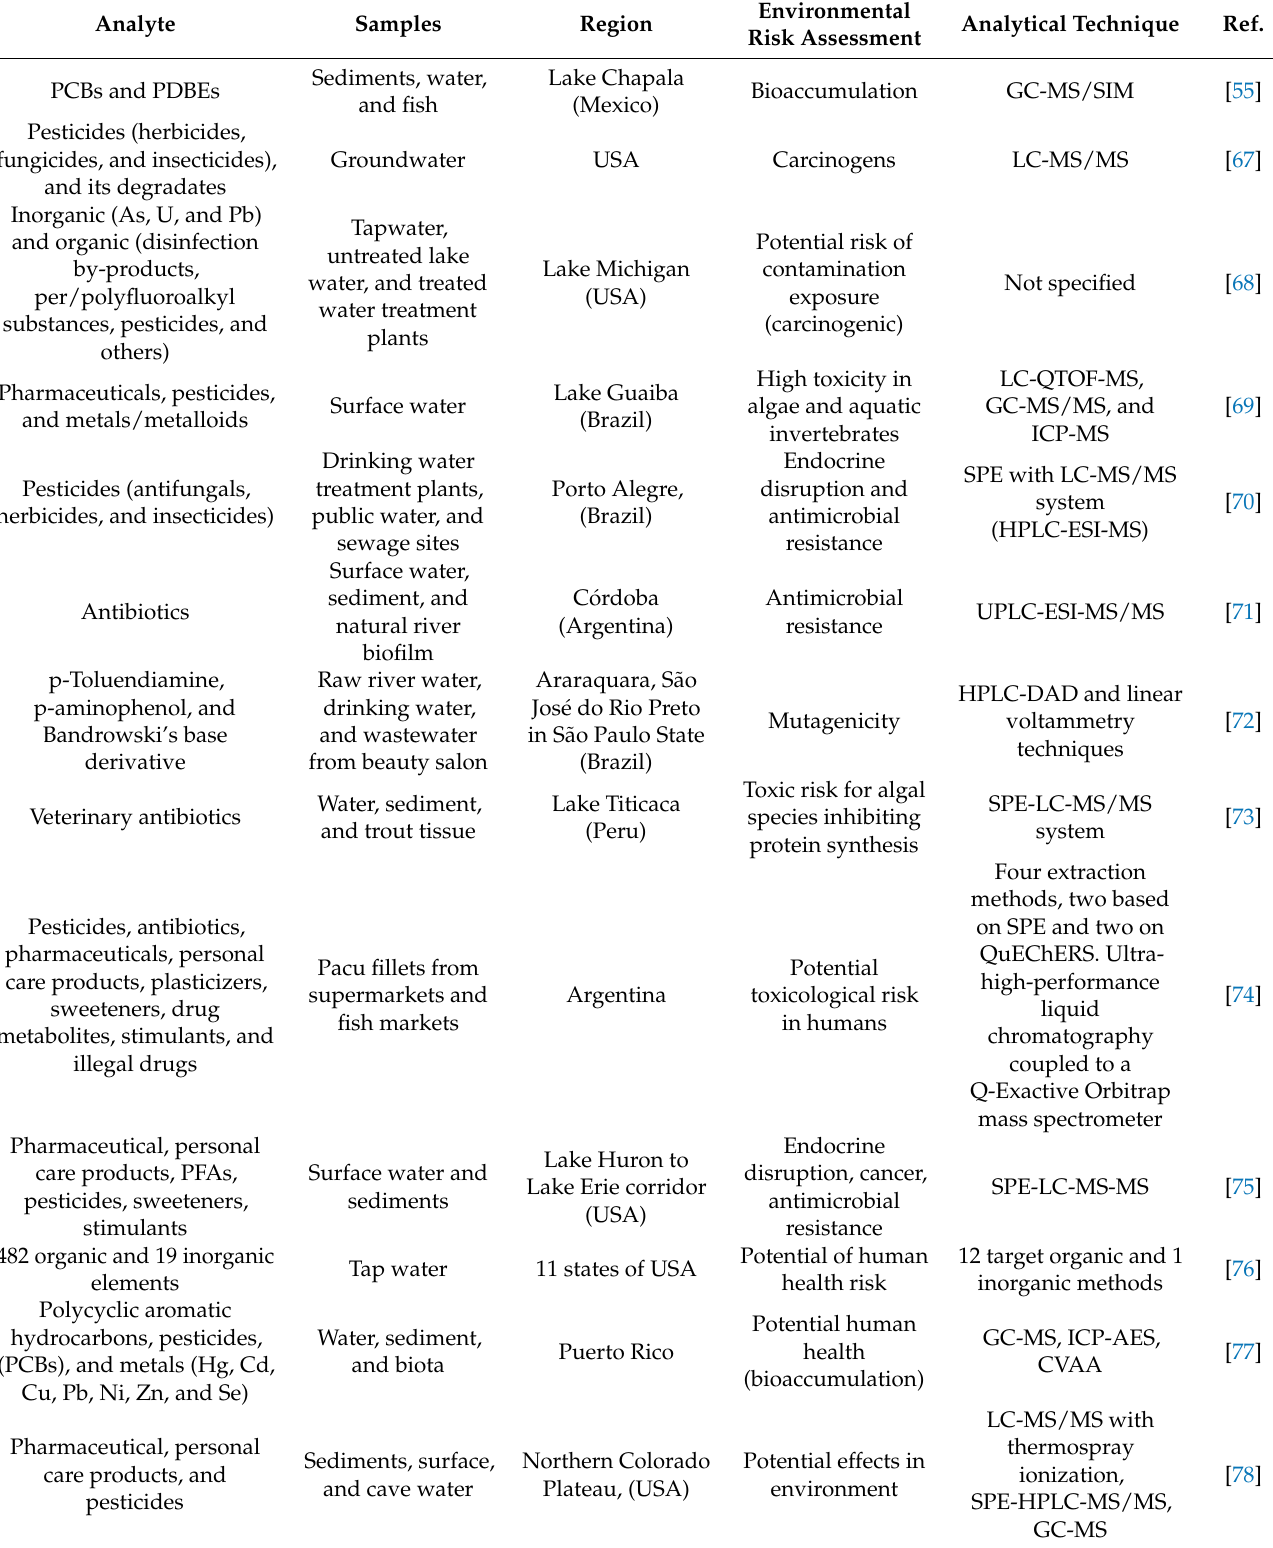
Table 2. Detection of organic pollutants in environmental